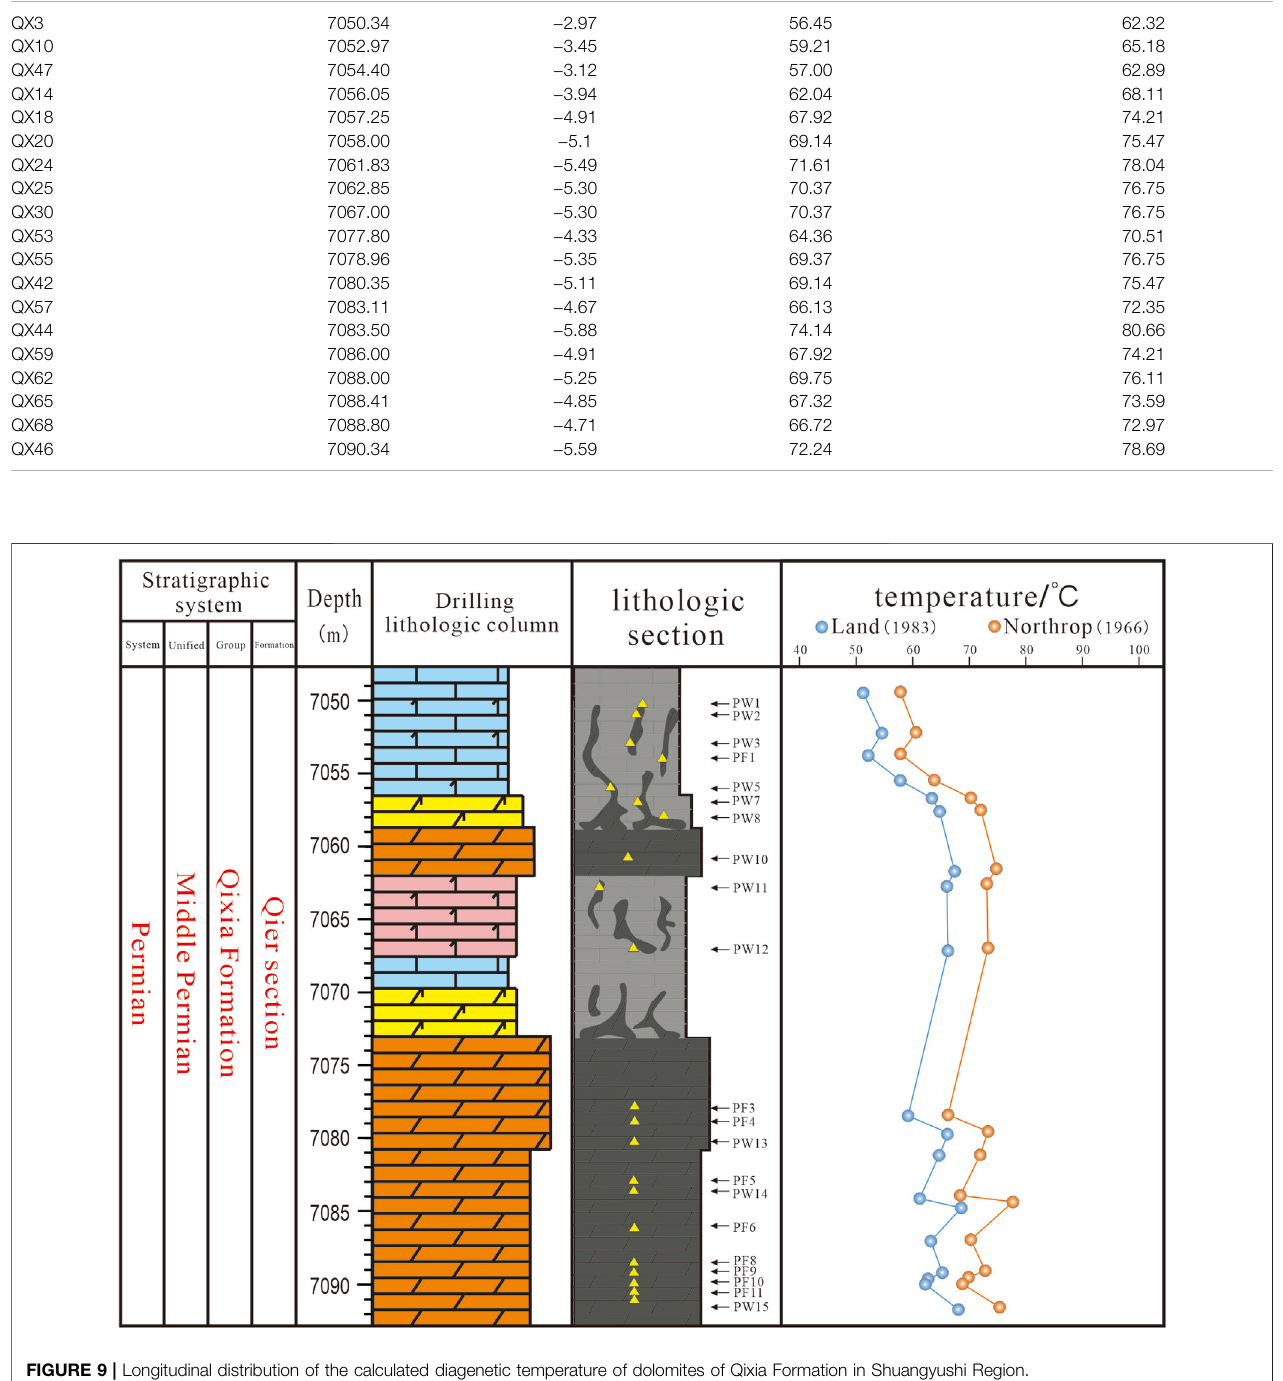
Frontiers in Earth Science |